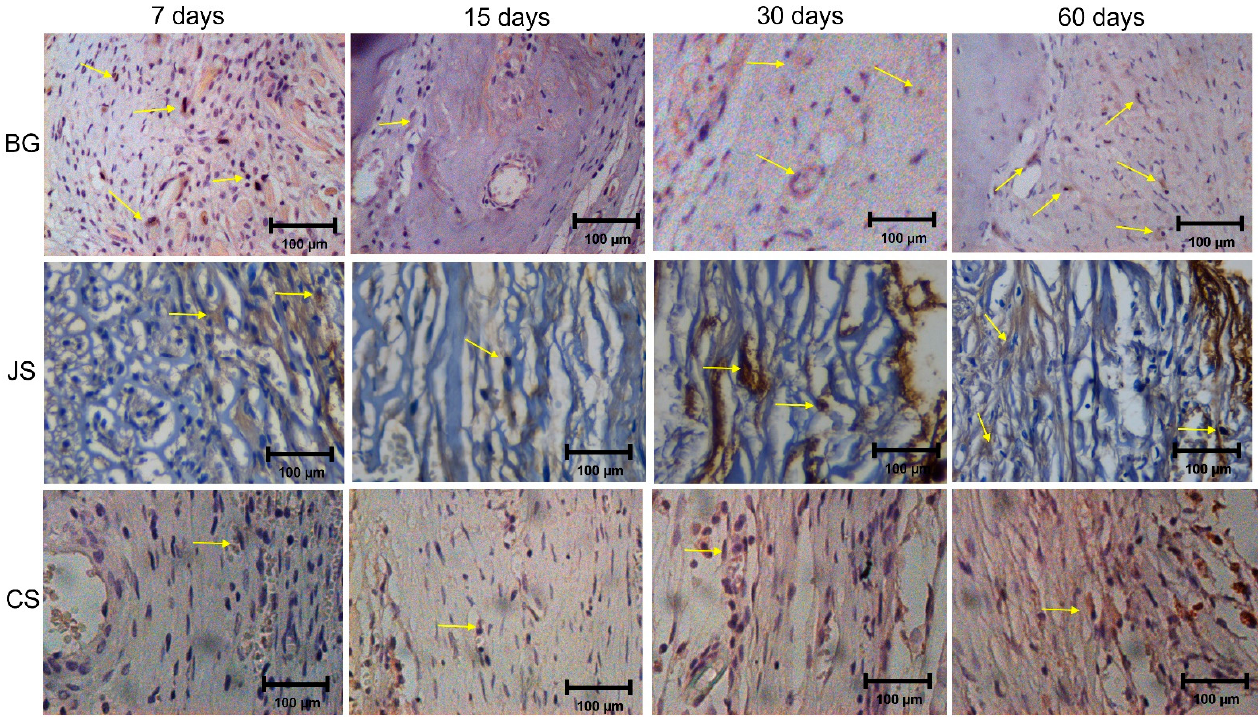
Figure 7. Photomicrographs of the immunohistochemical analyses at BG, JS, and CS group in 7, 15, 30, and 60 days highlight osteocalcin reaction at 40.0× magnification. The yellows arrow indicates the labeling.